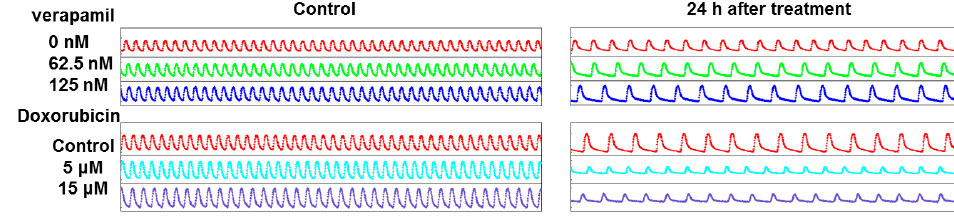
Figure 5. Long-term monitoring (24 h) after drug treatment.